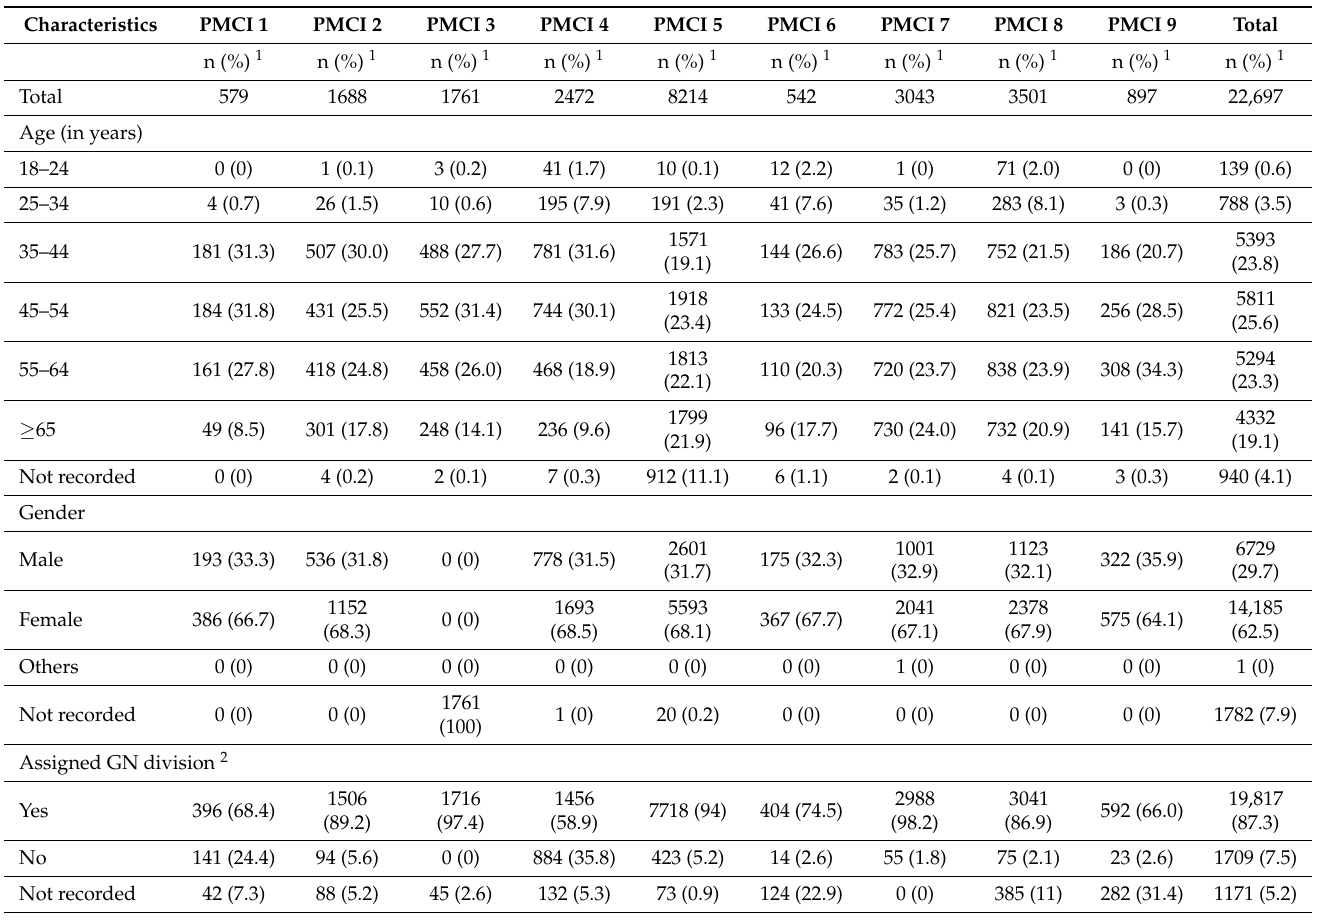
Table 2. Demographic and risk factor profile of the individuals who underwent screening for NCD risk in the selected PMCIs supported by the PSSP in Sri Lanka from June 2019 to May